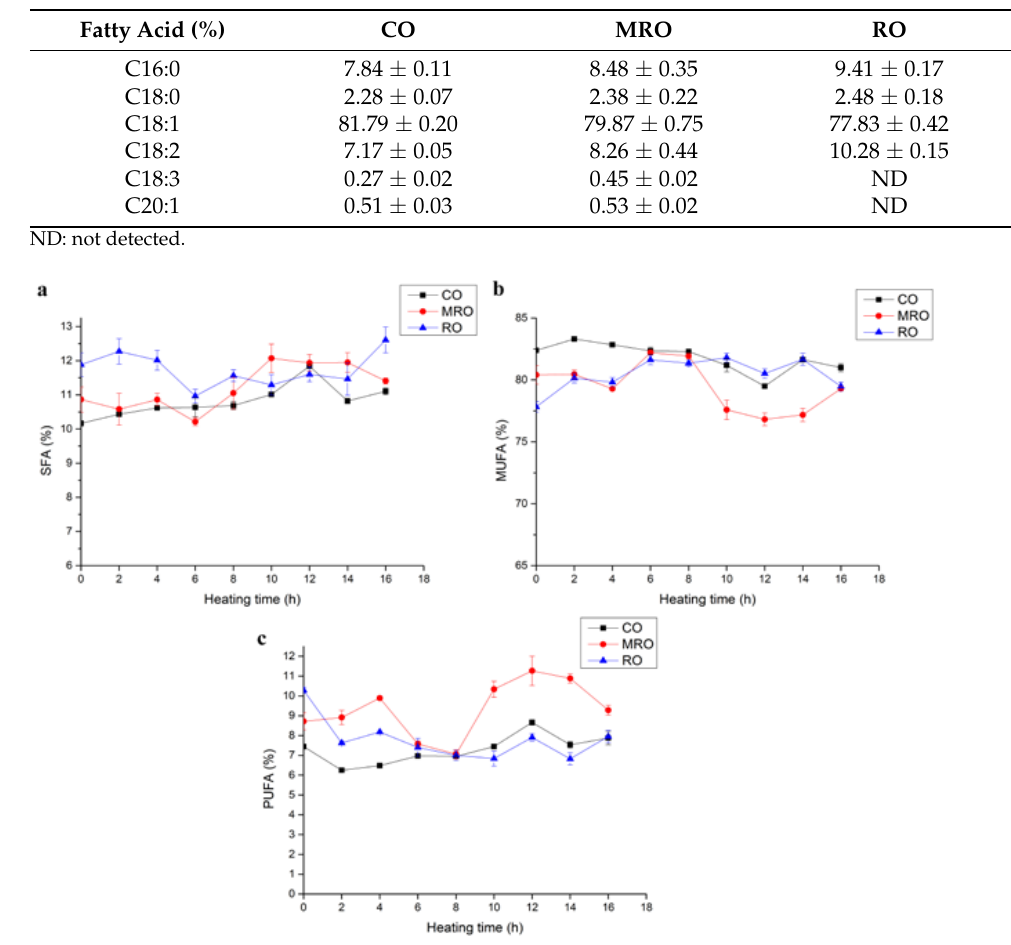
Figure 3. Changes in fatty acids in three kinds of camellia oil during heating. ( a ) Saturated fatty acids (SFAs); ( b ) monounsaturated fatty acids (MUFAs); ( c ) polyunsaturated fatty acids (PUFAs). Note: SFA is equal to the sum of myristic acid, palmitic acid, stearic acid, and arachidonic acid. MUFA is the sum of palmitoleic acid, oleic acid, arachidonic acid, erucic acid, and nervonic acid. PUFA is equal to the sum of linoleic acid and linolenic